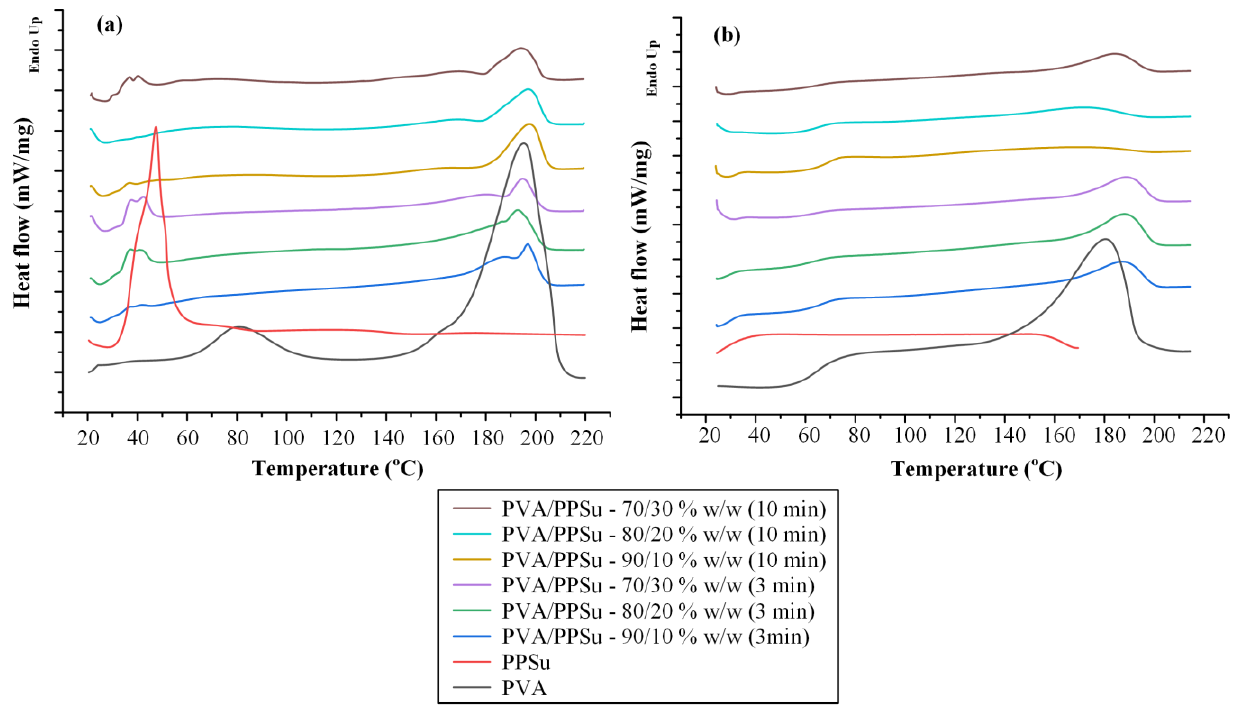
Figure 2. DSC thermograms after the 1st ( a ) and the 2nd ( b ) heating scans for the neat PVA/PPSu matrices. Table 1. Melting onset temperature (T m,onset ), glass transition temperature (T g ) and enthalpy of fusion (ΔH f ) results based on the obtained DSC thermograms for the neat PVA/PPSu matrices.